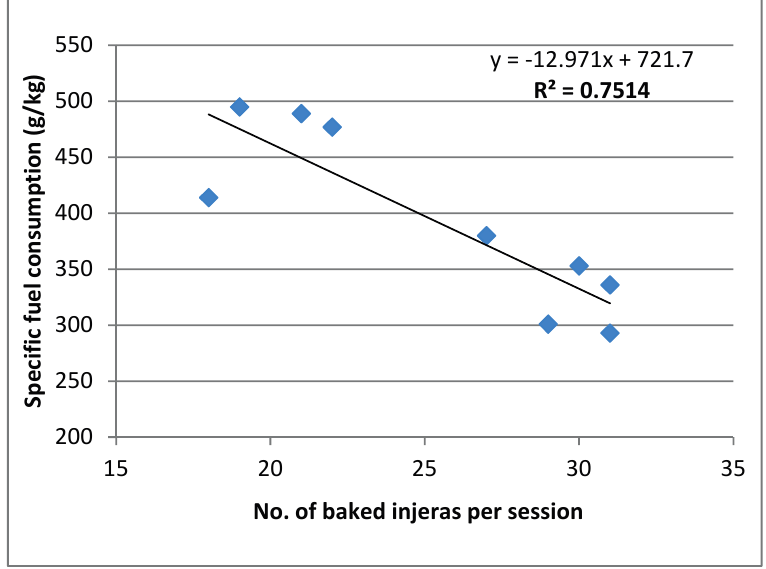
Figure 3. Linear regression of specific fuel consumption ( SC ) on the number of baked injera s per session using